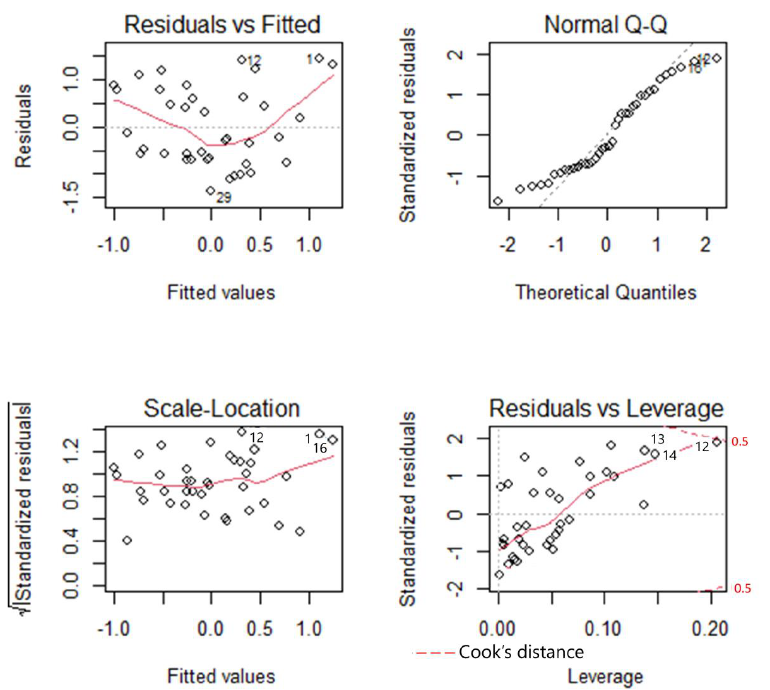
Figure A7. Model diagnostics for the best model with overall spring AA as the explained variable, and 15 climate variables and the Year as explanatory variables for the Chiffchaff Phylloscopus collybita (Table A16).